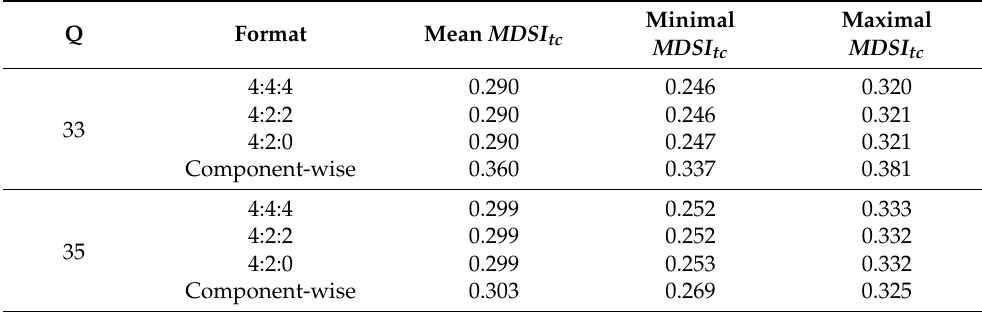
Table 6. Statistical data for comparison of compression variants’ performance characteristics ( MDSI tc